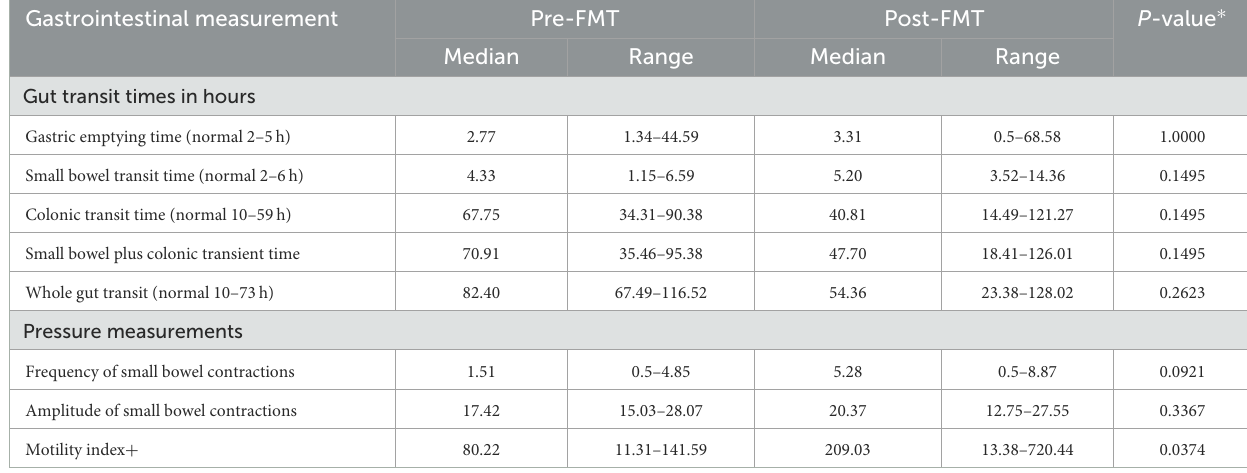
TABLE 4 Transit times and motility patterns determined by SmartPill determination pre- and post-FMT treatment in six patients. Gastrointestinal